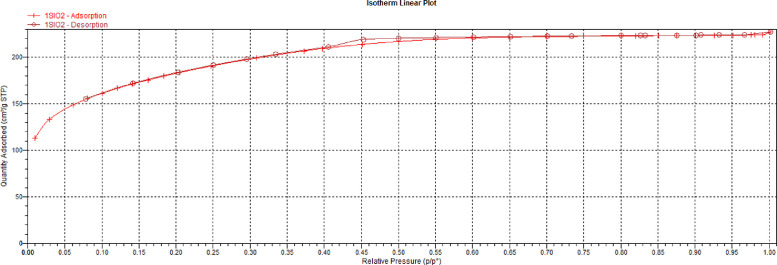
Linear Isotherm Plot for the Silica Gel (SiO2).